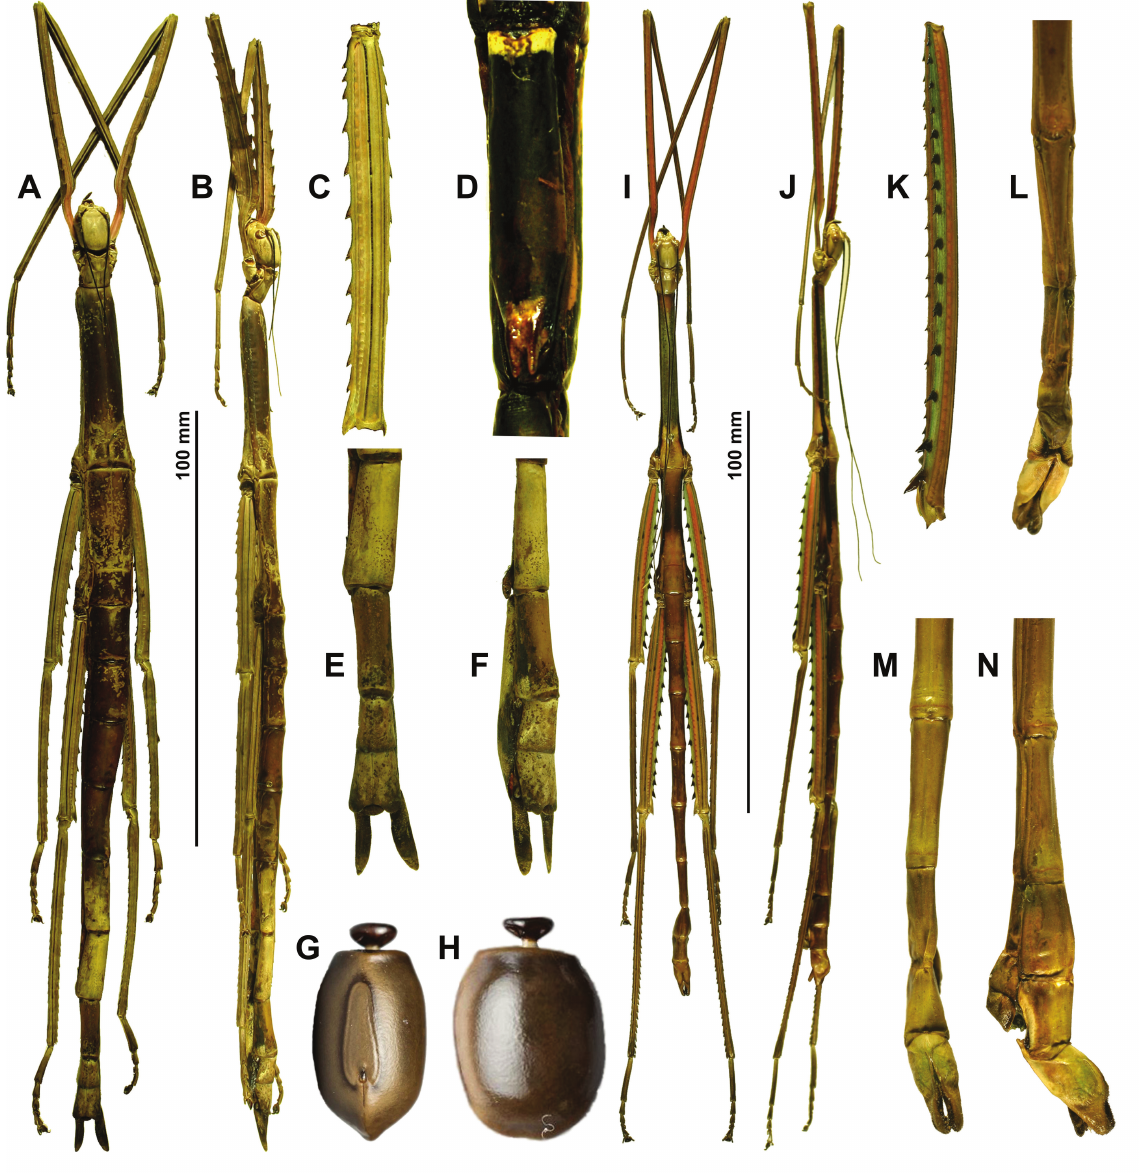
Fig. 5. Phryganistria tamdaoensis sp. nov. — A–F . ♀. A . Habitus, dorsal view. B . Habitus, lateral view. C . Mesofemur, lateral view. D . Sternum VII and praeopercular organ. E Apex of abdomen, dorsal view. F . Apex of abdomen, lateral view. — G–H . Egg. G . Dorsal view. H . Lateral view. — I–N . ♂. I . Habitus, dorsal view. J . Habitus, lateral view. K . Mesofemur, lateral view. L . Apex of abdomen, ventral view. M . Apex of abdomen, dorsal view. N . Apex of abdomen, lateral view. C–H, K–N = not to